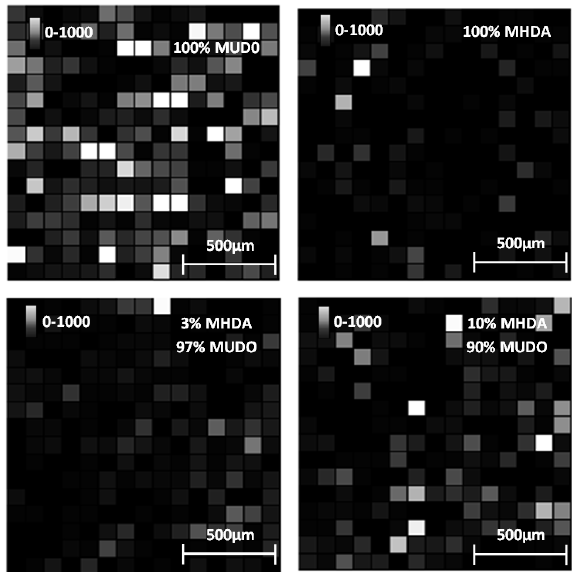
Figure 11. Intensity images (arbitrary unit) of the 1960 Da peak for each chemically functionalized GaAs surface after incubation in the RSA